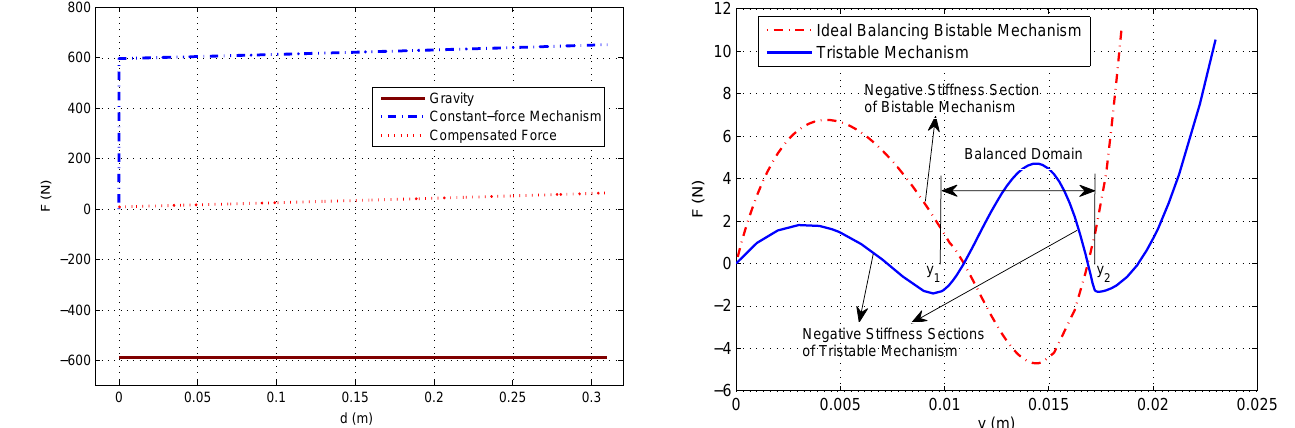
Figure 4. Force-displacement characteristics of an ideal balancing bistable